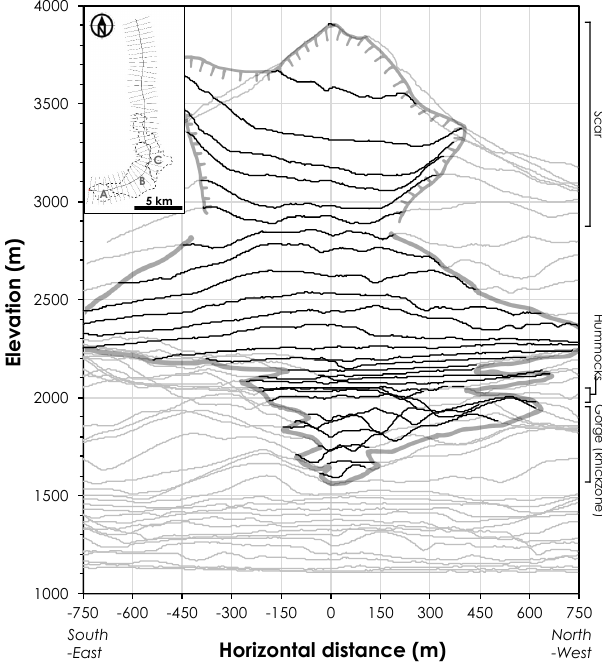
Figure 9. Transverse profiles across the DAD. Areas of the sec- tor collapse and the potential DAD extent are shown in black sur- rounded by thick gray lines. The inset map (upper left) shows the location of these sections along the main course of the debris avalanche over the mapped extent of the DAD. The alphabet marks (A, B, and C) in the inset correspond to those in Fig. 1.